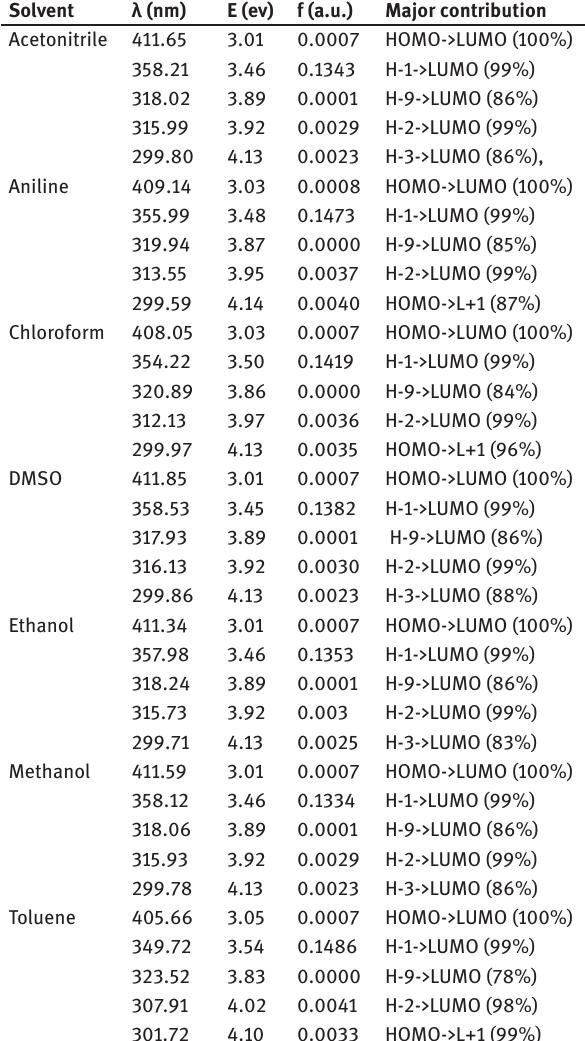
Table 3: The calculated absorption wavelengths (λ), excitation energies (E) and oscillator strengths ( f ) of the IPAONM molecule using B3LYP/311G(d,p)